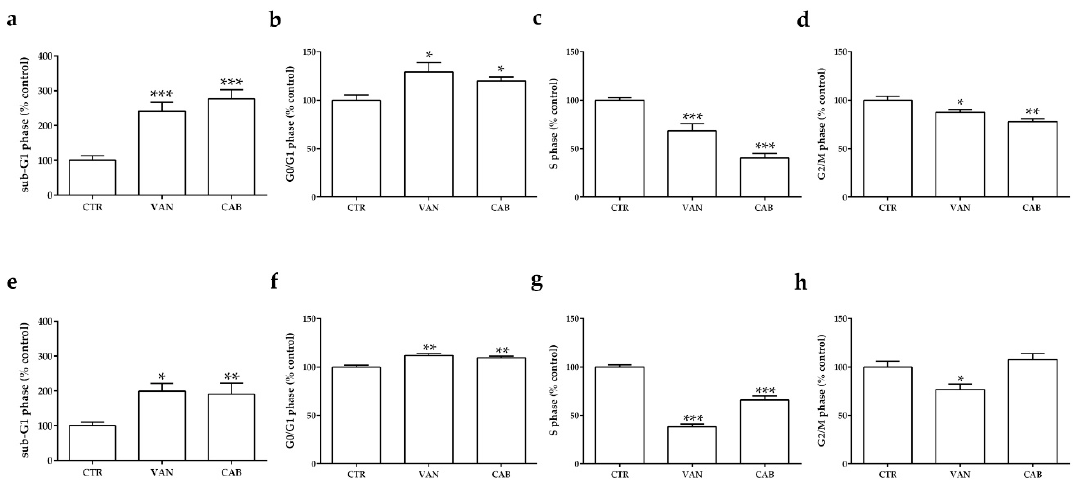
Figure 2. Effects of vandetanib (VAN) and cabozantinib (CAB) on the cell cycle in medullary thyroid carcinoma (MTC) cell lines. Cell cycle analysis after six days of incubation with VAN and CAB in TT ( a – d ) and MZ-CRC-1 cell lines ( e – h ). Cells were detected using FACS analysis after staining with propidium iodide. Control (CTR) values have been set to 100%. Cell cycle distribution is expressed as the percentage of cells in the G 0 /G 1 , S, and G 2 /M phases compared to the untreated CTR. Values represent the mean ± S.E.M. of at least three independent experiments. * p < 0.05; ** p < 0.01; *** p < 0.001.